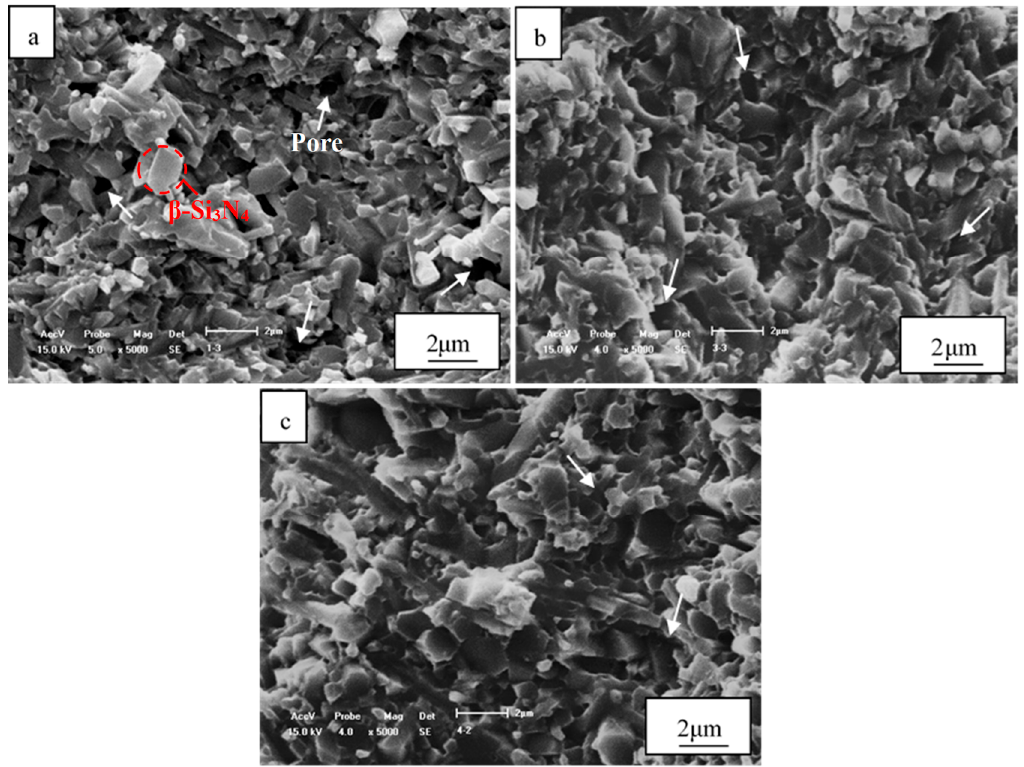
Figure 9. The fracture surfaces SEM of SN2, SN4, and SN5 samples sintered at different temperatures: ( a ) 1650 °C; ( b ) 1700 °C; ( c ) 1750 °C.